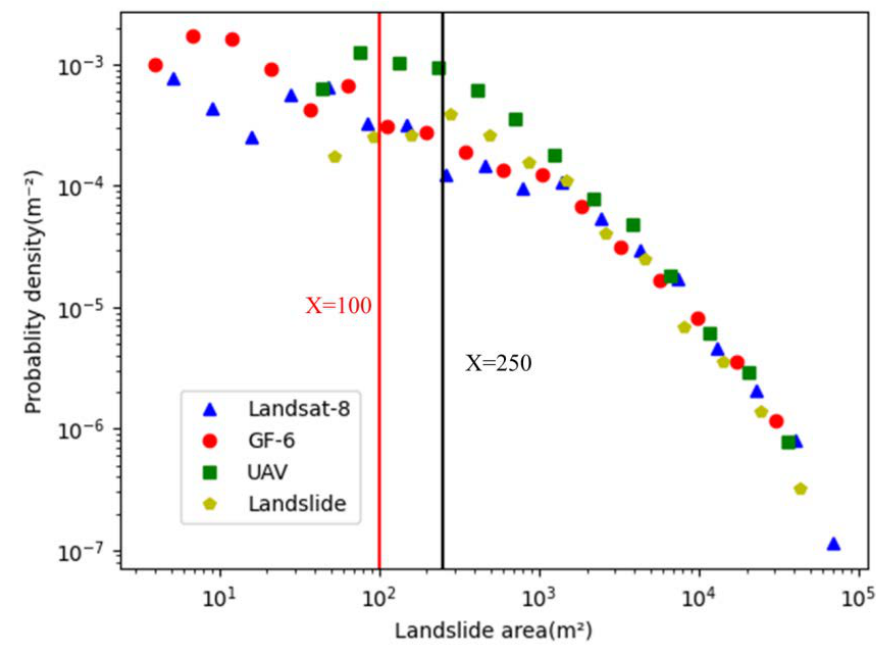
Figure 7. Frequency–area curves of landslides of remote sensing image. Table 4. Landslide indicators in each area of remote sensing images.